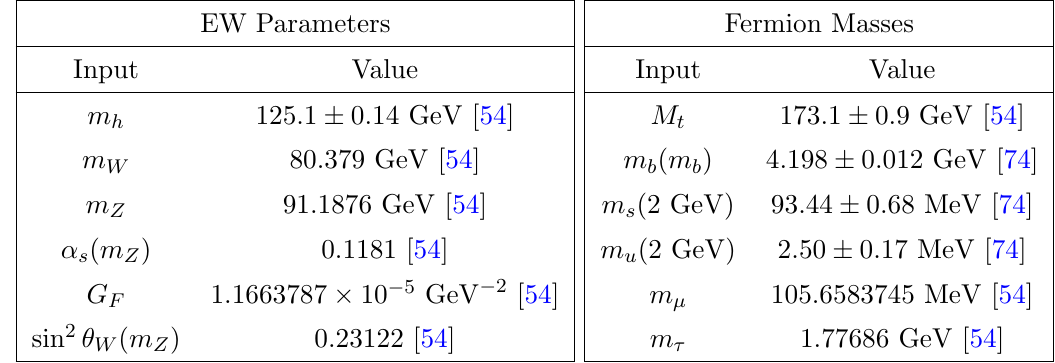
Table 3 . Fundamental parameters of the SM. The uncertainties are used for the evaluation of theoretical uncertainties in the (cid:13)avor analysis. The top mass is the on-shell mass and the other quark masses are the MS masses with the renormalization scale shown in the parentheses.